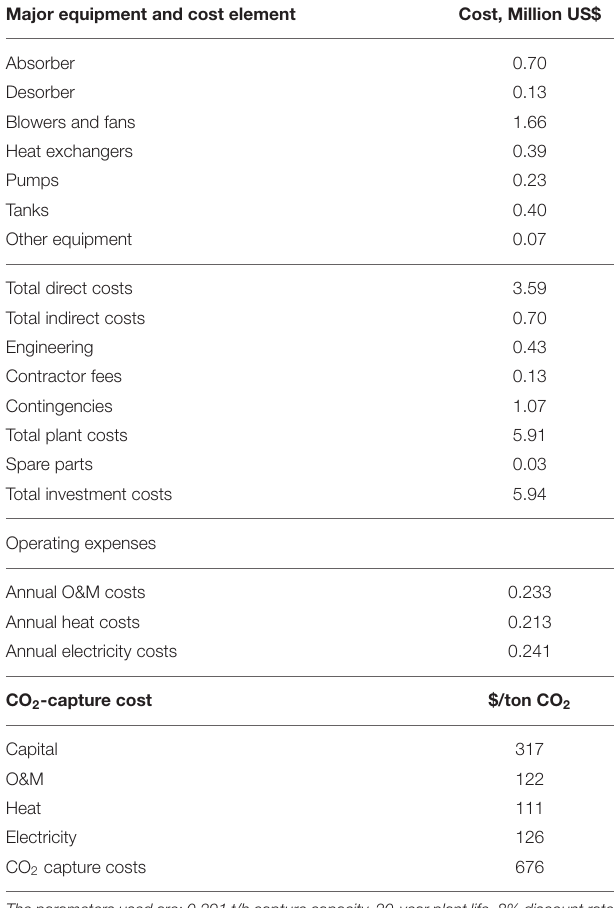
TABLE 5 | Economic performance of an improved amine-based air capture